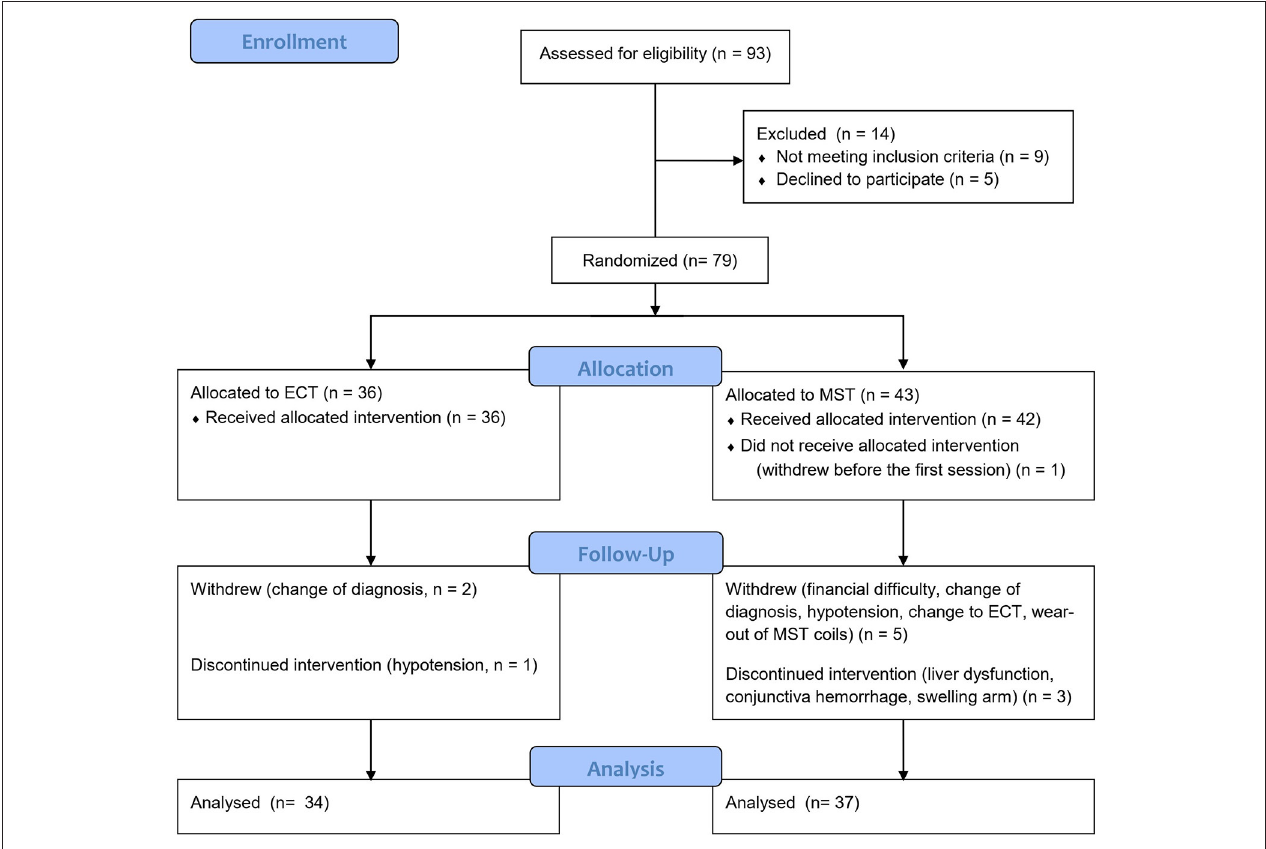
FIGURE 1 | Study flow chart of the ongoing randomized controlled study. MST, magnetic seizure therapy; ECT, electroconvulsive